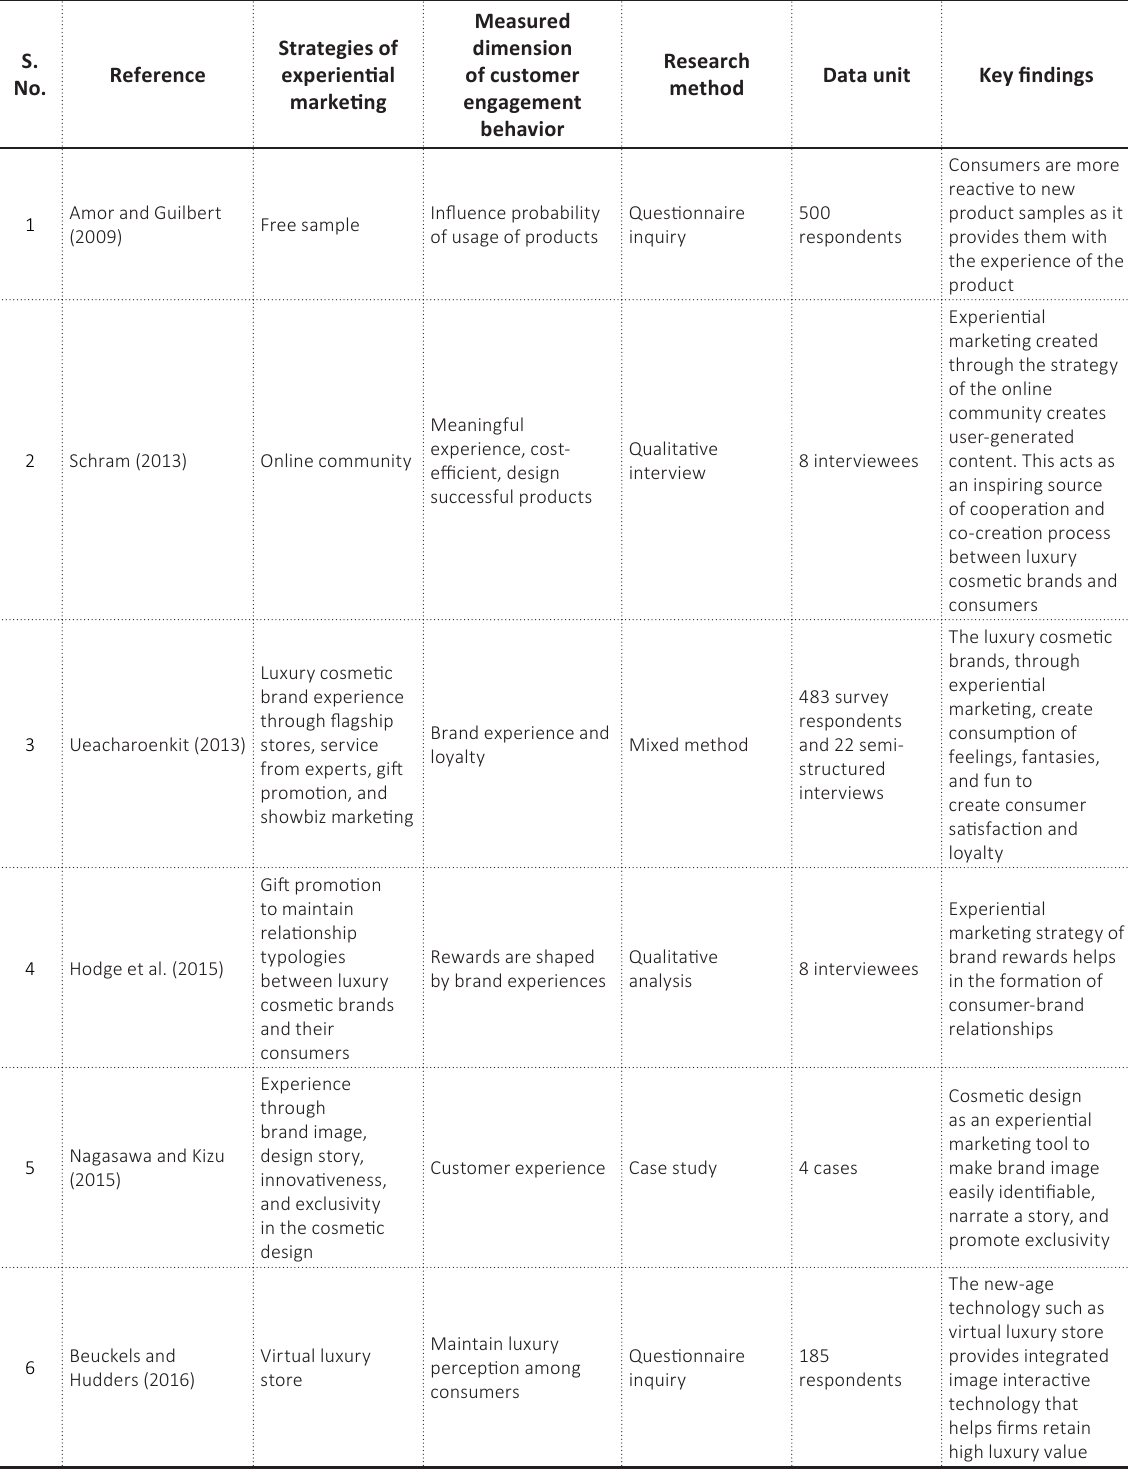
Table 1. Strategies of experiential marketing used by luxury cosmetics companies